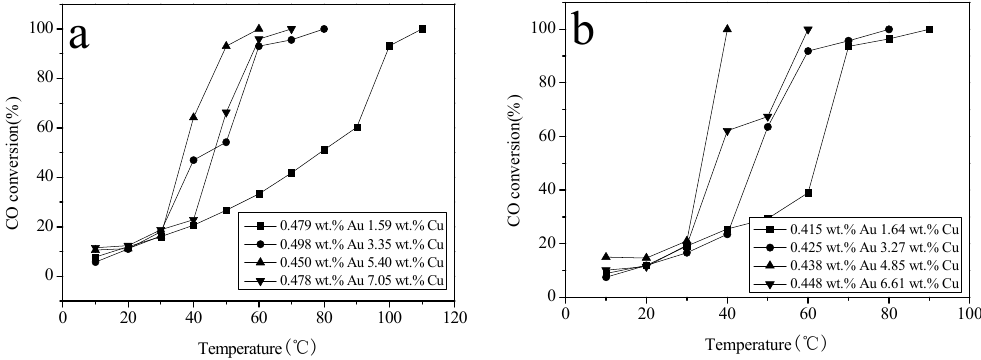
Figure 9. Catalytic activities of Au – CuO/Bi 2 WO 6 ( a ) and Au – CuO/Bi 2 WO 6 ‐ 400 ( b ).